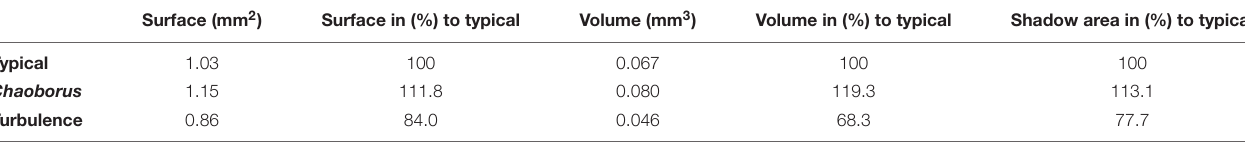
TABLE 2 | Alterations in surface, volume and “shadow area”.